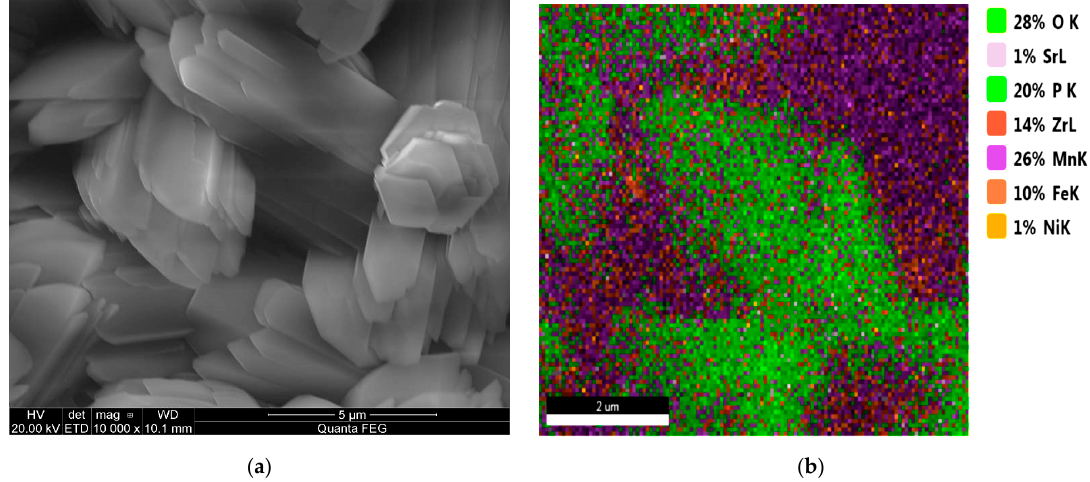
Figure 9. Coating produced from a phosphating bath containing strontium nitrate ( a ) and EDS image ( b ).